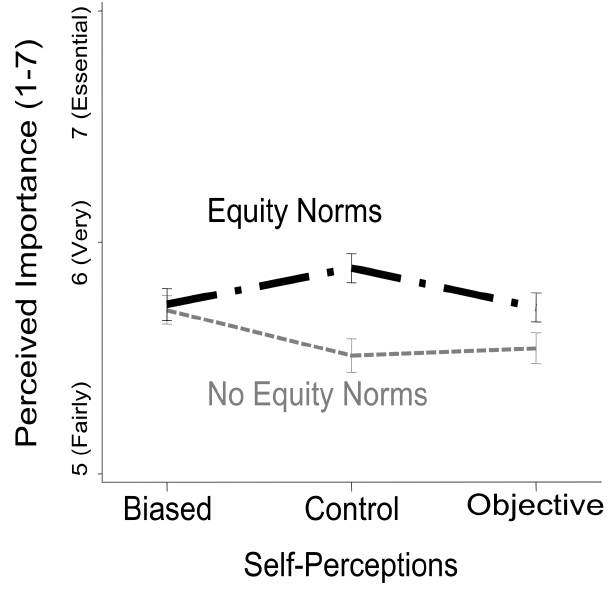
Figure 2. Mean differences in the perceived importance of the job applicants’ expertise in the hiring decision are represented as a function of the self-perceptions experimental manipula- tion (as either biased, objective, or control) and whether equity norms were present or absent; error bars represent the standard